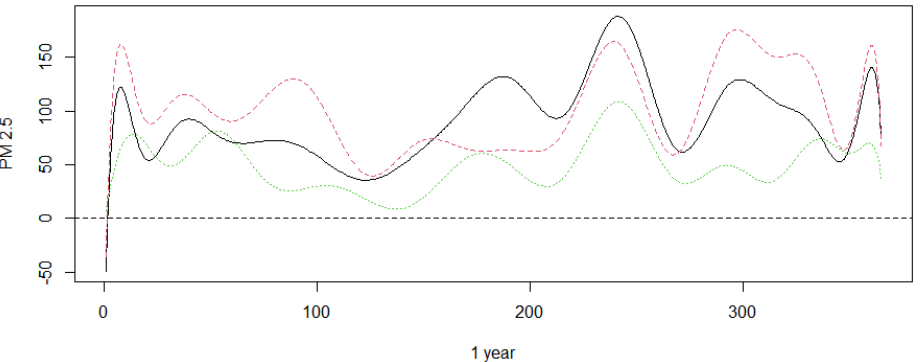
Figure 1. The mean PM 2.5 ( µ g/m 3 ) of Beijing, Tianjin, and Shijiazhuang from December 2019 to January 2019. The black line stands for Beijing. The red dasehed line stands for Tianjin. The green dotted line stands for Shijiazhuang.